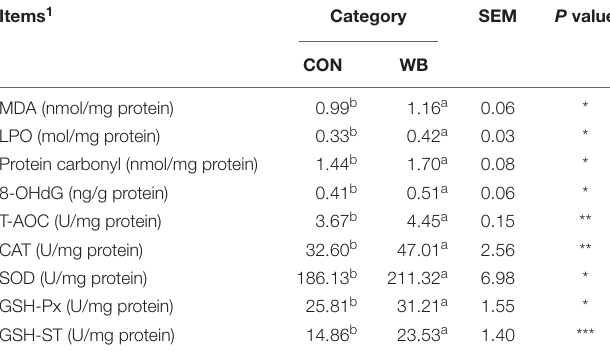
TABLE 2 | Oxidative products and antioxidant ability in liver tissues of broiler chickens with normal (CON) and wooden breast (WB) pectoralis major muscle ( n =